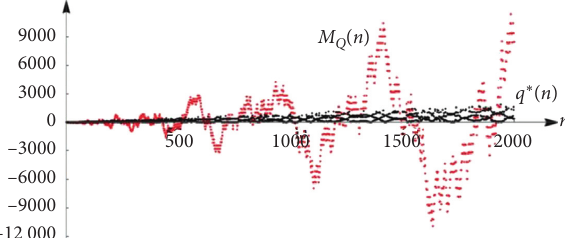
( n ) (red colored) and q ∗ ( n ) (black Q